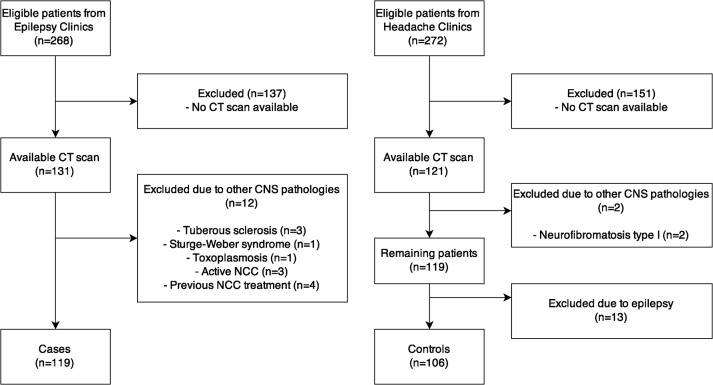
Flow diagram of enrolled cases and controls.Flow diagram showing on the left side how cases were selected and on right side how controls were selected. As can be seen, the number of eligible patients that were excluded due to not having an available CT scan was the largest exclusion criteria in both groups. CT = brain computed tomography scan, CNS = central nervous system, NCC = neurocysticercosis.